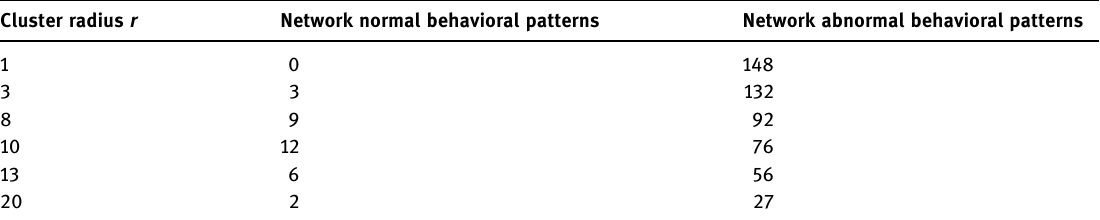
Table 5: Normal data clustering table